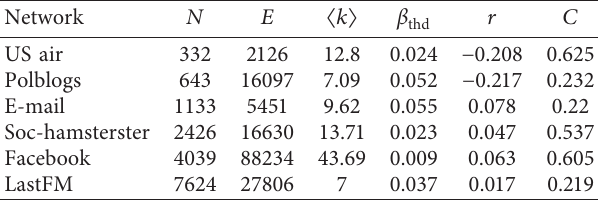
Table 1: There are six fundamental statistical attributes in the six networks, such as N , E , 〈 k 〉 , β , r , and C . N and E , respectively, thd , r , and C , represent the number of nodes and edges. 〈 k 〉 , β thd respectively, represent the average degree, epidemic threshold, degree assortativity, and clustering